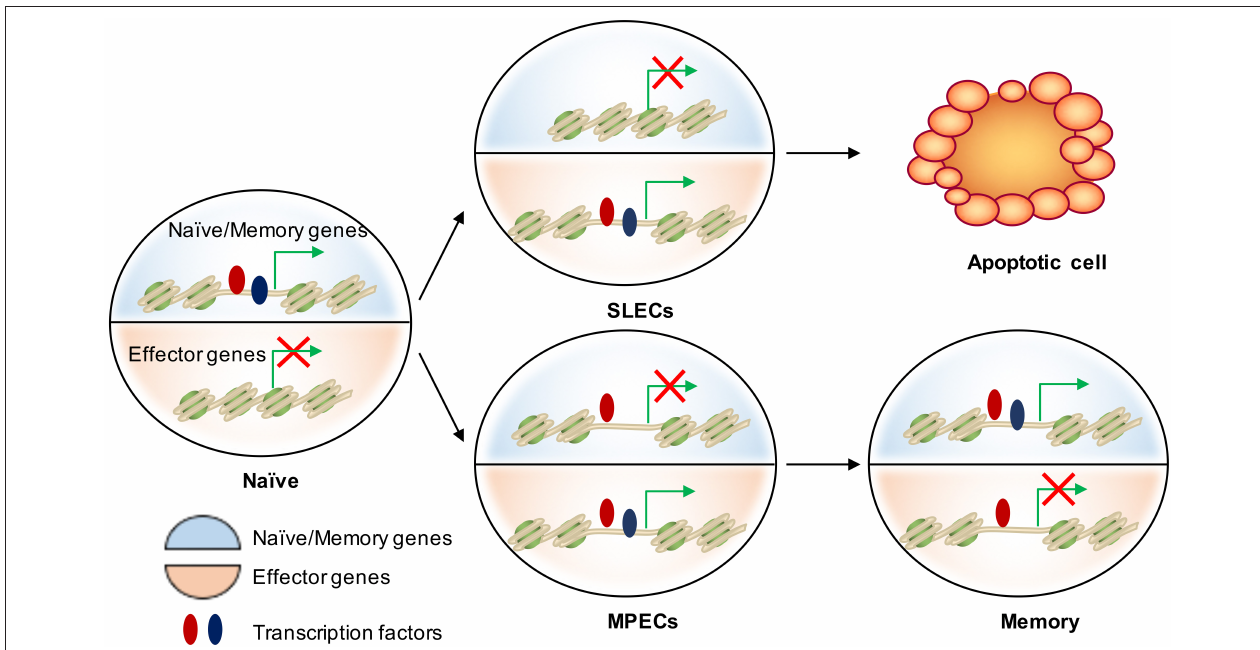
FIGURE 3 | Epigenetic regulation of cell fate decision during acute infection. There are two major transcriptional circuits in regulating CD8T cell differentiation: one of them associated with effector function and another one is essential in naïve/memory cells controlling T cell quiescence and homeostasis. In naïve CD8T cells, naïve/memory genes are open (epigenetically by TFs in red) and on (transcriptionally by TFs in blue), while the effector genes are closed and off. When naïve cells are activated, effector genes are turned on mainly by “pioneer TFs” (in red) in both SLECs and MPECs. These genetic regions remain open but poised as MPECs develop into memory cells. Transcriptional repression of naïve/memory genes in MPECs cells can be reversed in memory CD8T cells through recruiting additional TFs (in blue) to restart gene expression. In contrast, SLECs lose the accessibility at these TF-bound cis-regulatory elements and therefore permanently turn off the naïve/memory gene expression. This leads to their loss of memory potential and long-term